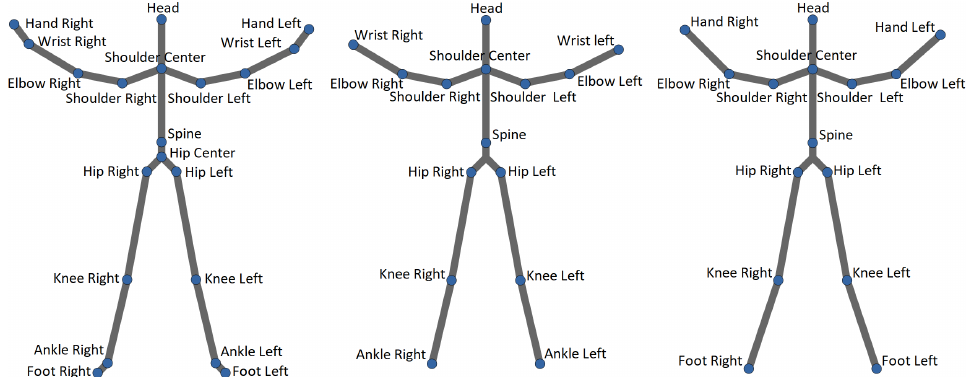
Figure 3. Three skeletons available in datasets: ( left ) MSRA, UTD-MHAD, UTK, and SYSU; ( middle ) FLORENCE; ( right )